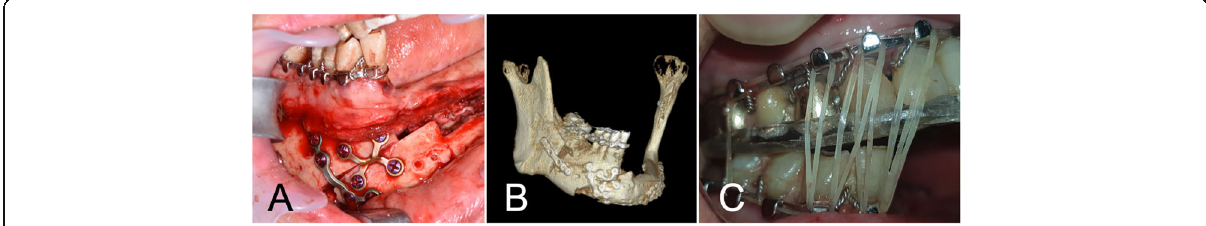
Fig. 3 Secondary surgery for the reestablishment of occlusion and facial symmetry. a Sliding osteotomy at the anterior junction between FFF and #42 tooth on the mesial side. b 3D reconstruction image of CT scan after SSRO of the right mandible and sliding osteotomy of the anterior mandible. c Elastic intermaxillary fixation with occlusal wafer after restoration of normal